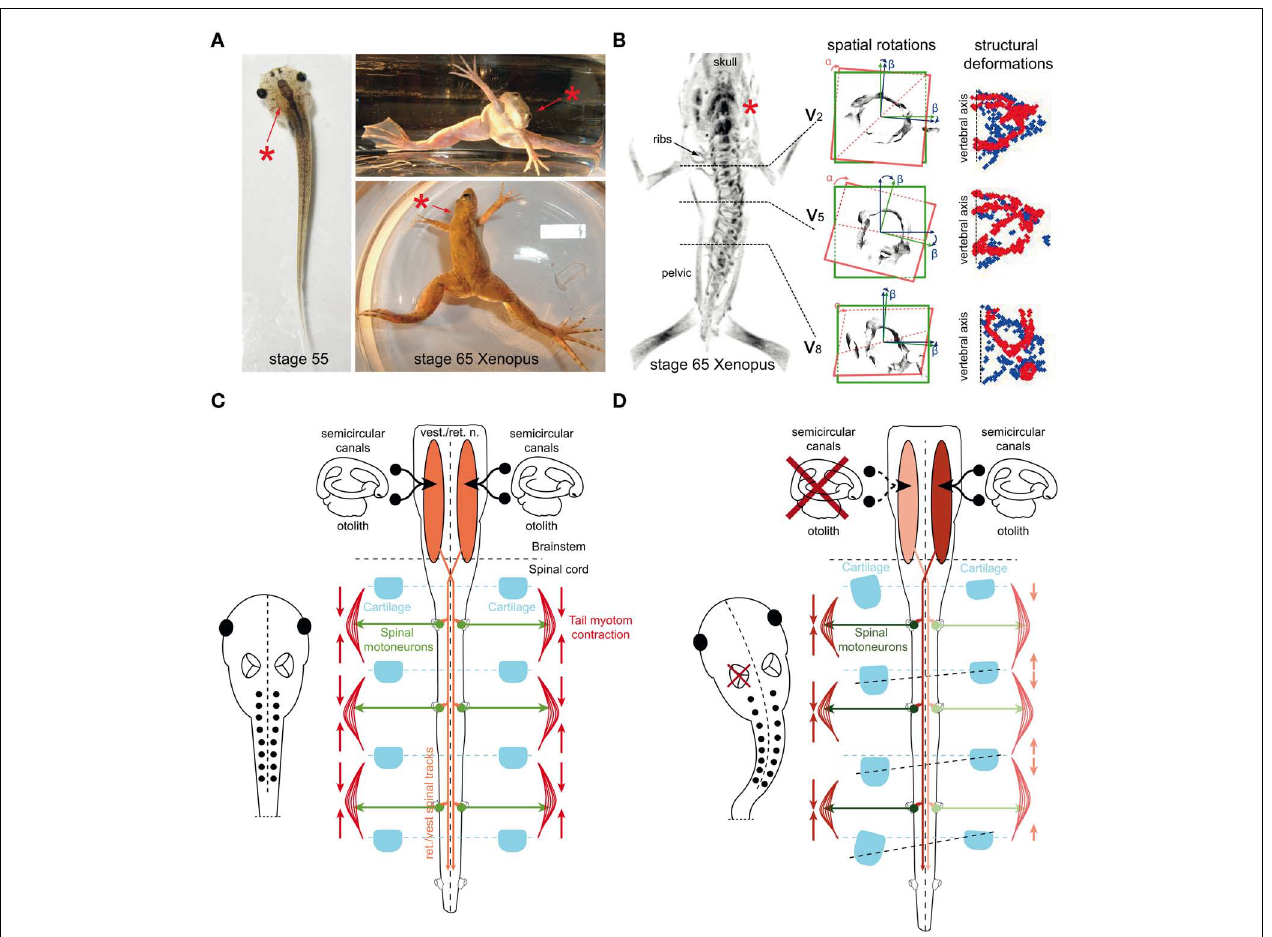
cross-sections in the right row show the structural deformation ofV2,V5, and V8 as a function of the symmetry between left (red) and right (blue) hemi-vertebrae. (C,D) Presumed causality between a UL, development of a permanent postural asymmetry and skeletal deformation; the balanced/imbalanced bilateral activity in descending brainstem-spinal pathways, spinal motoneurons and axial musculature determines the skeletal symmetry in controls (C) and the deformation after permanent asymmetric contractions following UL on the left side (D) . Modified and adapted from Lambert et al.